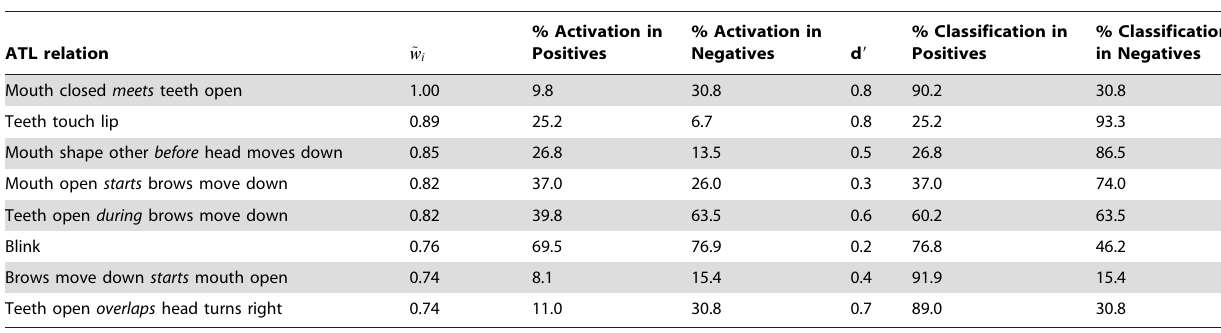
Table 9. Discriminant features for polarity in Wh-questions.